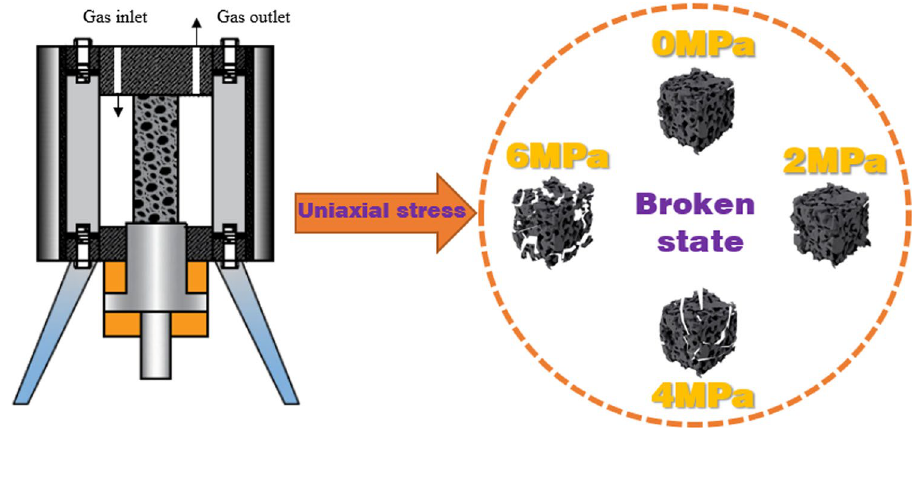
Fig. 9 Mechanism of coal re- ignition under uniaxial